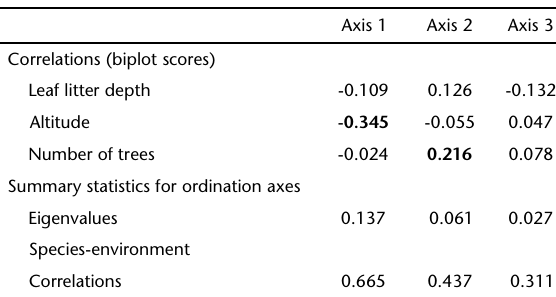
Table II. Summary of the CCA performed for three features used to characterize plots and anuran species distribution among them at the Reserva Ecológica de Guapiaçu, southeastern Brazil. The variable scores with the highest influence in the first two axes are shown in